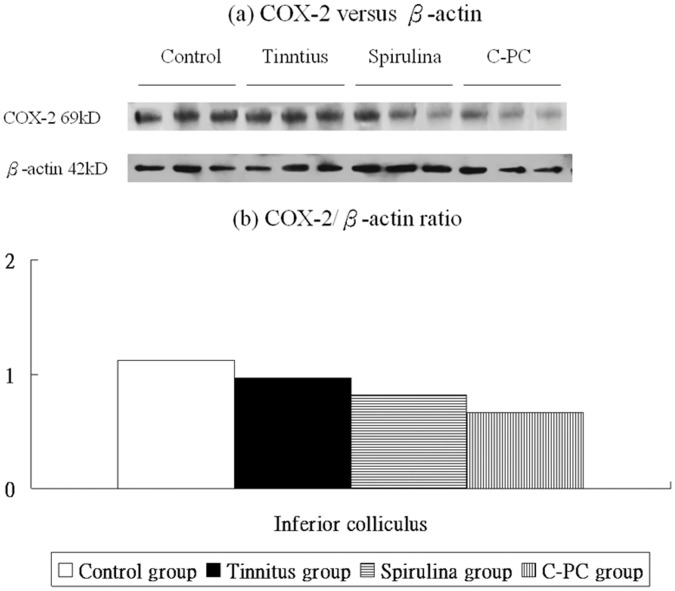
The levels of COX-2 protein expression in the IC (a,b).There are not significant differences in these levels among the four groups.